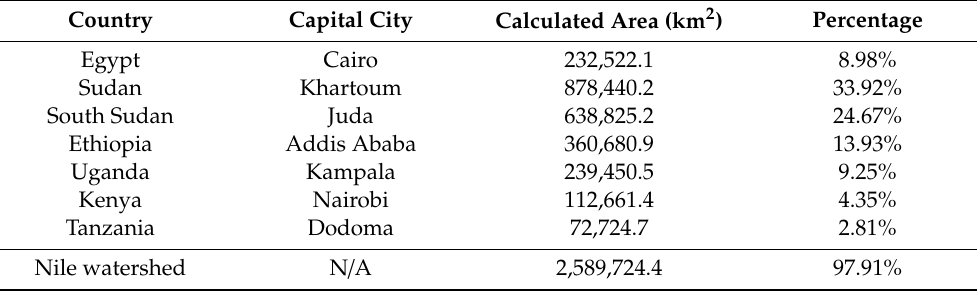
Table 1. The countries in the Nile watershed under investigation in this